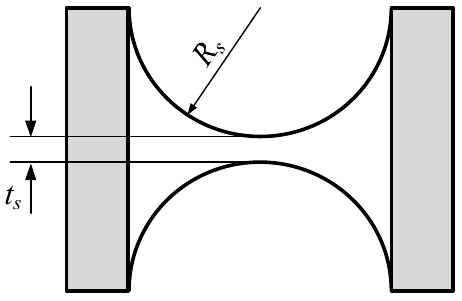
Figure 11. The schematic diagram of flexure spherical hinge structure.